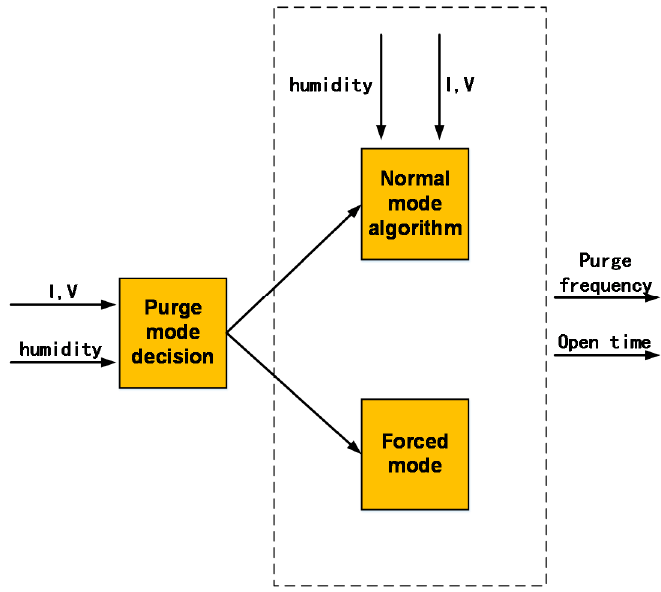
Figure 8. Purge control strategy.